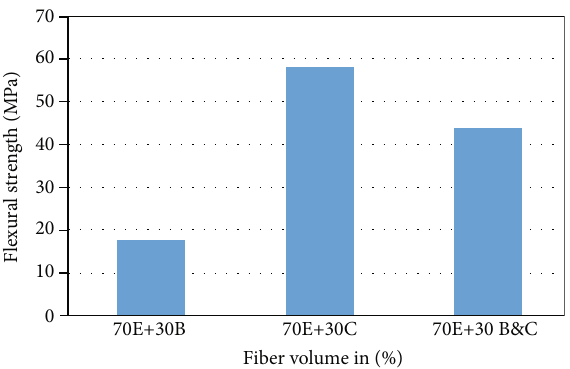
Figure 8: Flexural strength for various fi ber